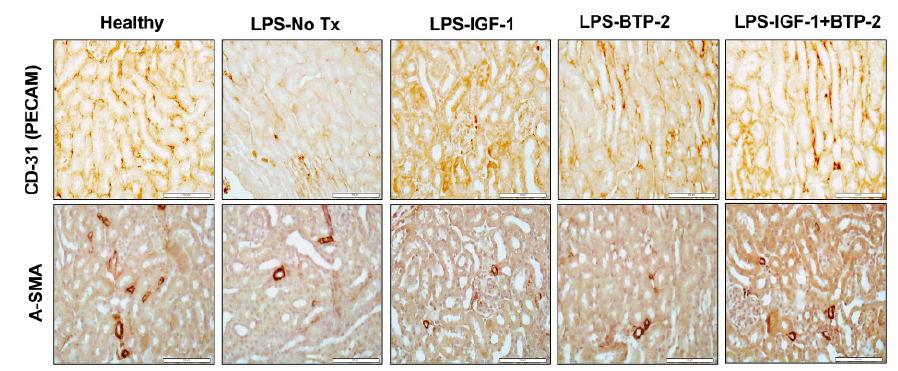
Figure 9. E ff ects of LPS in therapies on renal vascular integrity histologic parameters. (Upper panel) CD31 (PECAM) histology staining of renal sections, (Lower panel) a-SMA histology staining of renal sections (original magnification 40×; Scale bar, 100 µm).